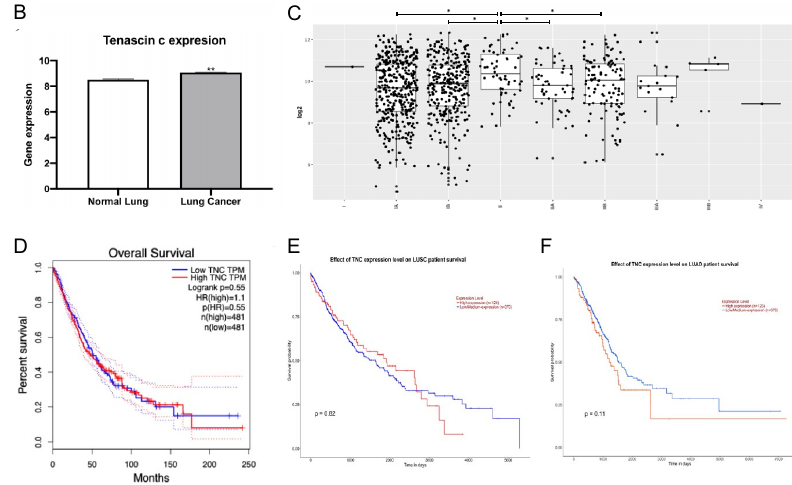
Figure 6. TNC expression is increased in lung cancer, but does not correlate with lung cancer sur-